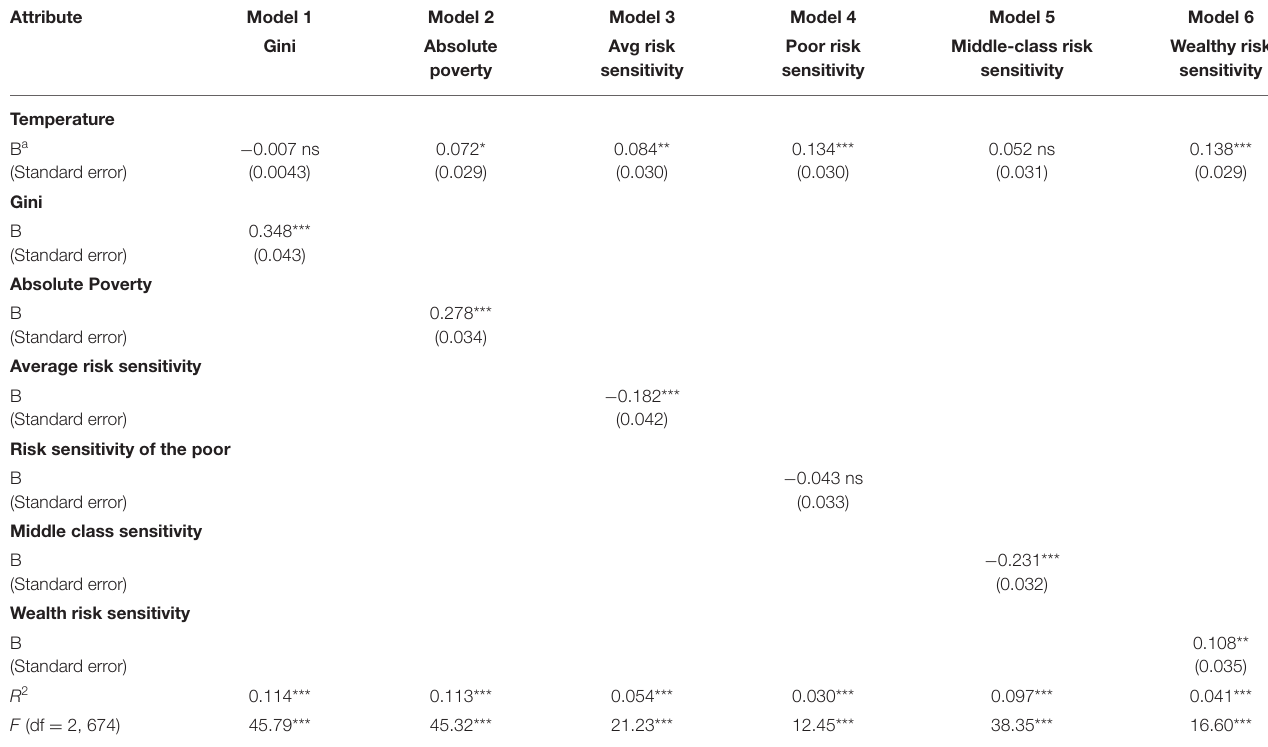
TABLE 2 | Comparison of linear models of the effects of inequality and temperature on Ln homicide